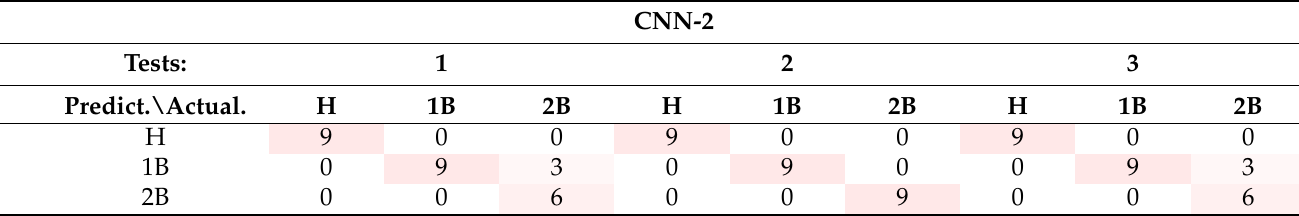
Table 8. Confusion matrix of the CNN-2 model with fault type classification.